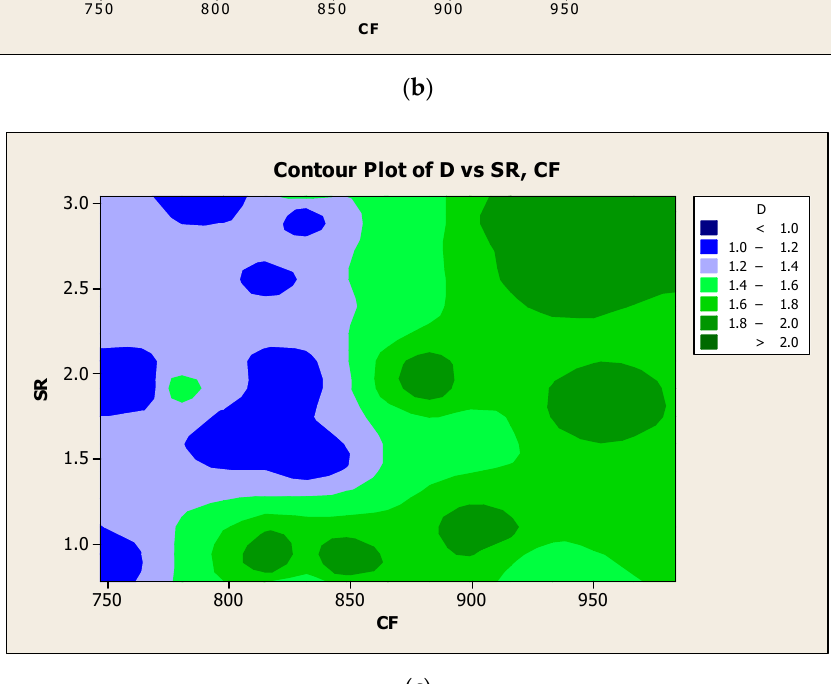
Figure 19. Contour diagrams with respect to SR and CF for ( a ) N, ( b ) F, and ( c ) D.